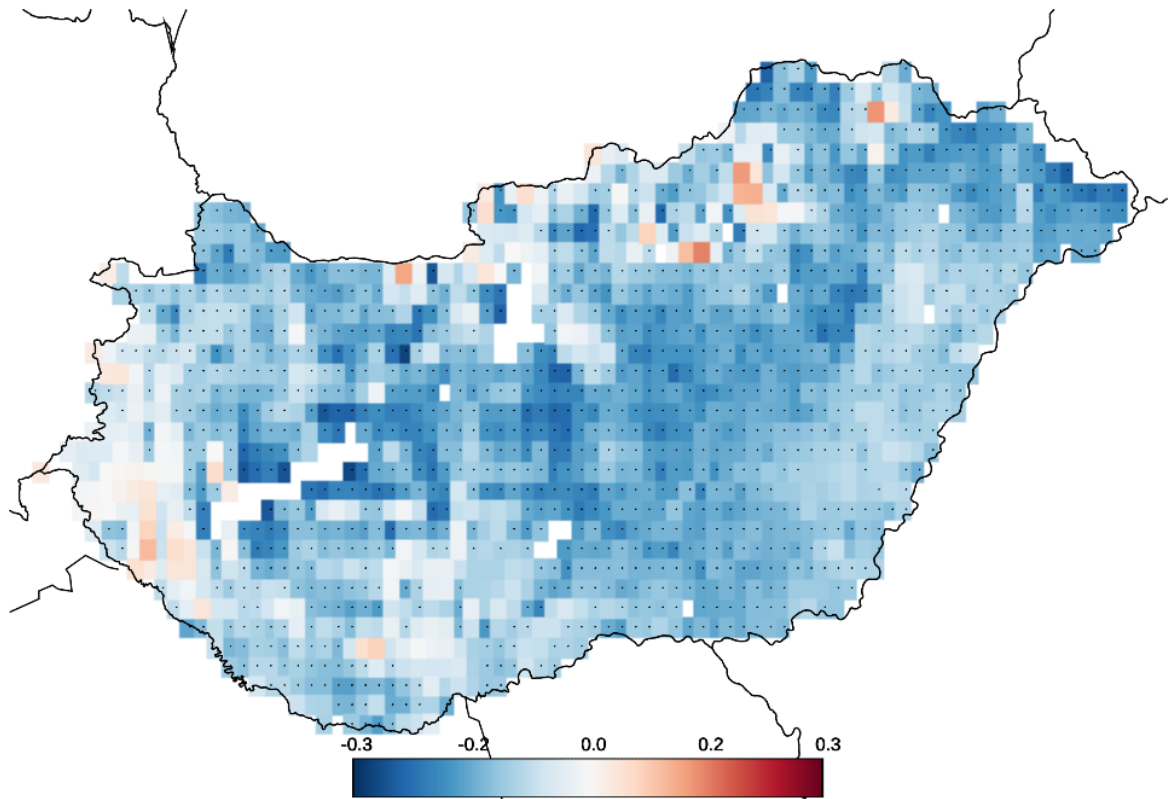
Figure 4. Heat map indicating the relative contribution of model (blue cells) and meteorological dataset (red cells) preference in explaining the observed start of spring (SOS) variability. Dots denote statistically significant differences ( p < 0.05).